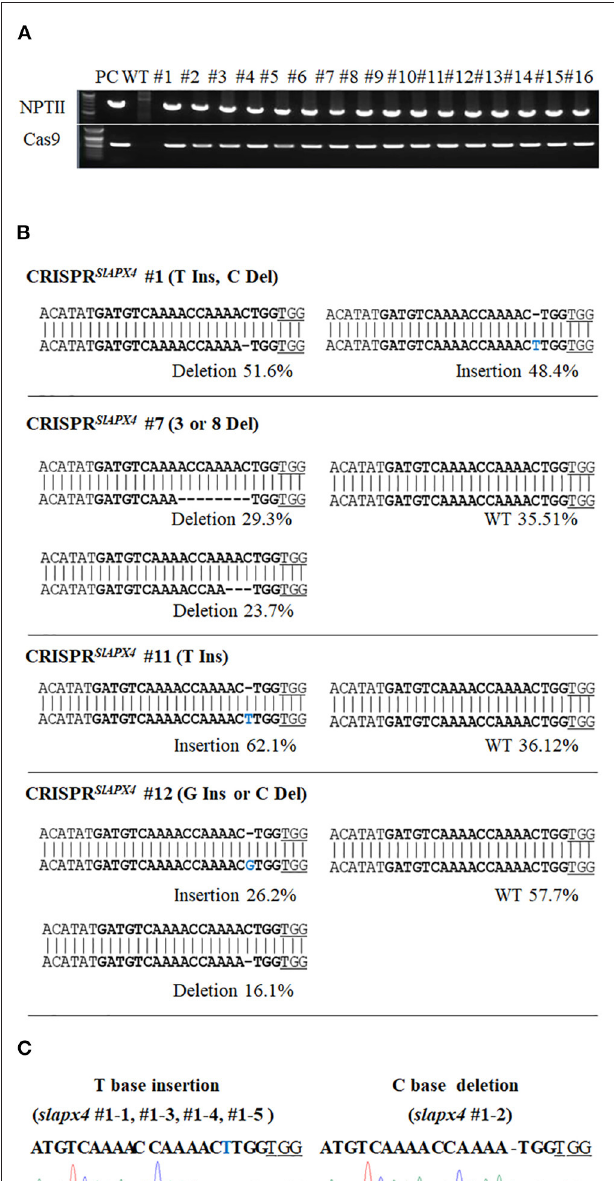
FIGURE 2 | Generation of SLAPX4 mutant plants. (A) Validation of transgenic plants using NPTII and Cas9 -specific PCR reactions. (B) Sequencing analysis of SlAPX4 locus targeted by a single-guide RNA (sgRNA). Genomic DNA extracted from the T 0 stage of CRISPR SlAPX 4 transgenic tomato plants was used for amplification of the SlAPX4 genomic region targeted by a sgRNA through PCR reactions. The PCR products were then applied for targeted deep sequencing analysis. (C) A representative chromatograph of edited alleles in the T 1 stage of SLAPX4 mutant plants was shown with the mutated target region. Bold, sgRNA target site; blue, base insertion; underlined, PAM site.